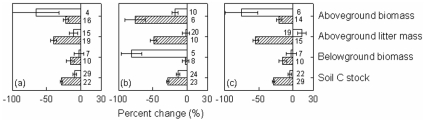
Percent change of ecosystem C pools from natural forests to plantations with two different groups in relation to land-use history (a), site preparation (b) for plantations, and study regions (c).Bars represented mean±95% CI. Values near each bar indicated the number of cases synthesized. Note: open bar- (a) afforestation, (b) unburnt, and (c) tropic; hatched bars- (a) reforestation, (b) burnt, and (c) temperate.